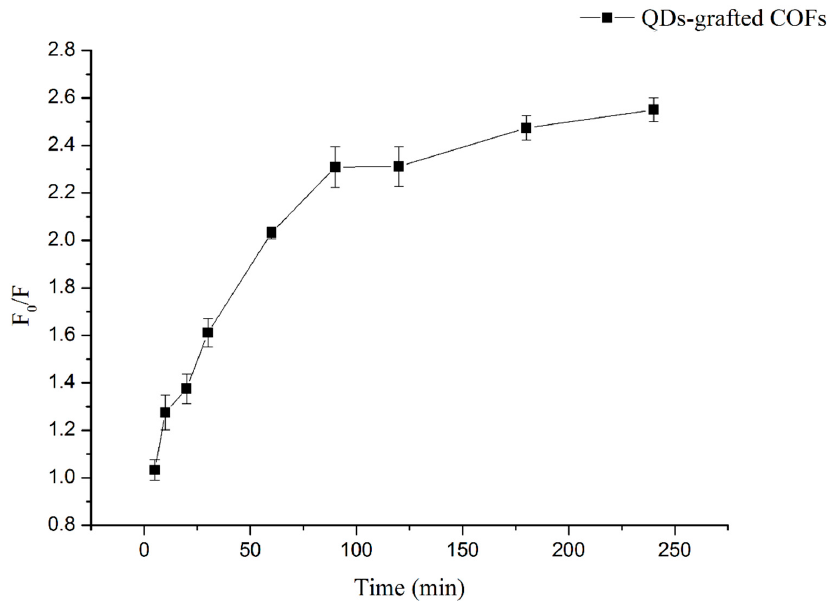
Figure 3. Kinetic adsorption of quinoxaline-2-carboxylicacid (QCA) (1 µ mol L − 1 ) onto QDs-grafted COFs.